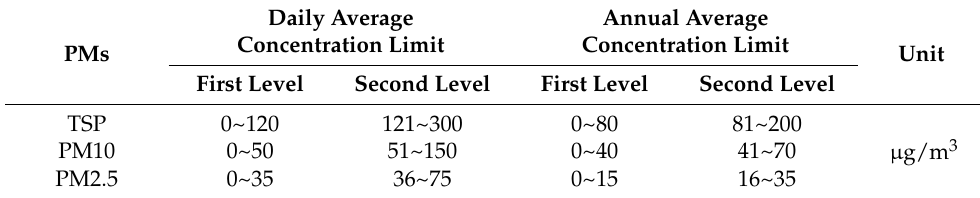
Table 4. Limits for the PM concentration.